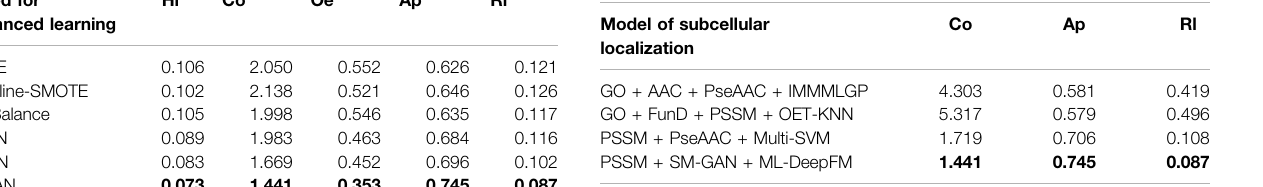
TABLE 1 | Comparing SM-GAN with other oversampling methods. TABLE 2 | Comparing Gm-PLoc with other model of protein subcellular